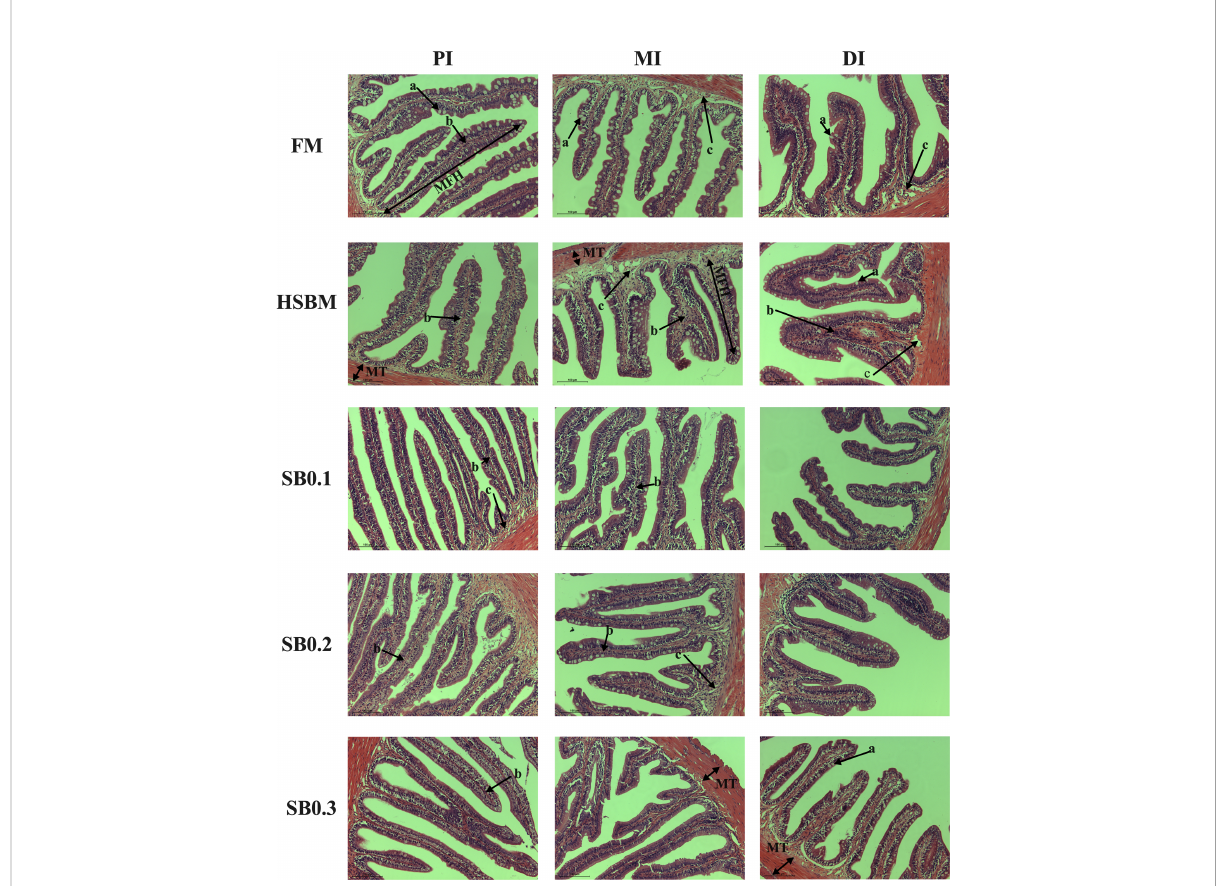
FIGURE 3 Intestinal histological examinations of sodium butyrate (SB) addition in high soybean meal (SBM) diets on the proximal intestine (PI), mid intestine (MI), and distal intestine (DI) in groupers in a 56-d feeding period (magni fi cation 200 X, scale bar = 100 mm). FM, fi sh meal; HSBM, 60% FM protein replacement with SBM in FM diets without SB addition; SB0.1, SB0.2 and SB0.3, 0.1%, 0.2%, and 0.3% SB were added in the HSBM diets, respectively. MFH, mucosal fold height; MT, muscular thickness; a, goblet cell; b, lamina propria; c, submucosa.